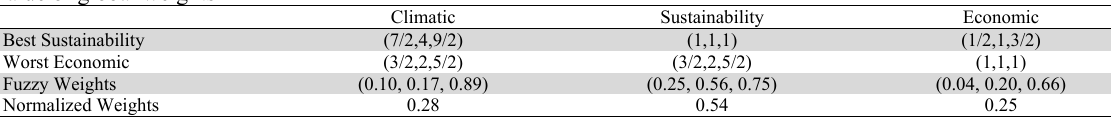
Value of global weights